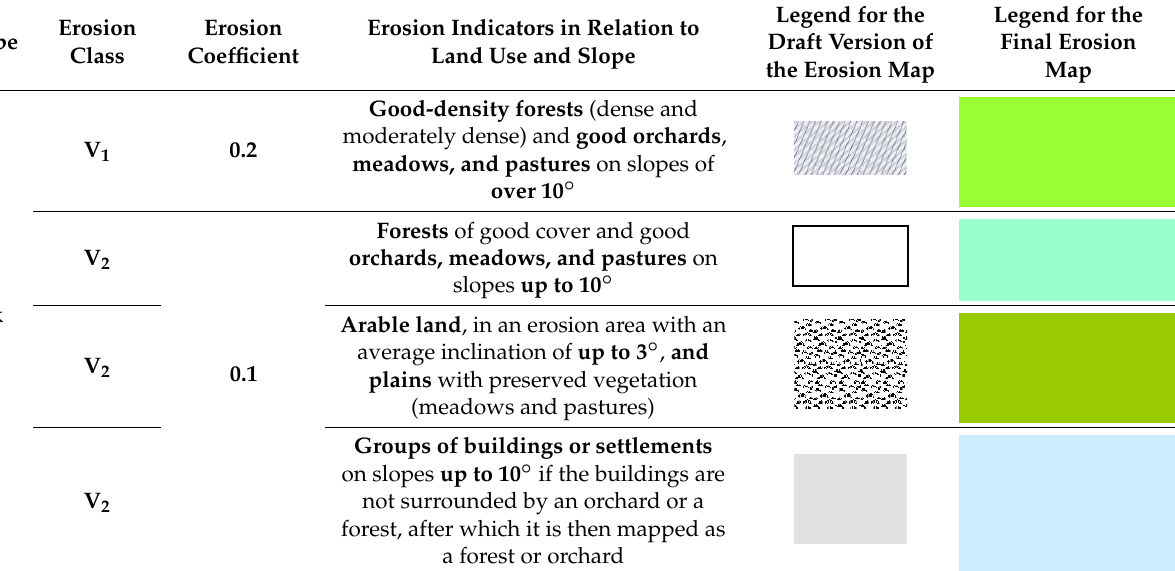
Figure 2. Example of land ‐ use maps for 1970 ( left ) and 2018 ( right ) for the settlement of Zuce.